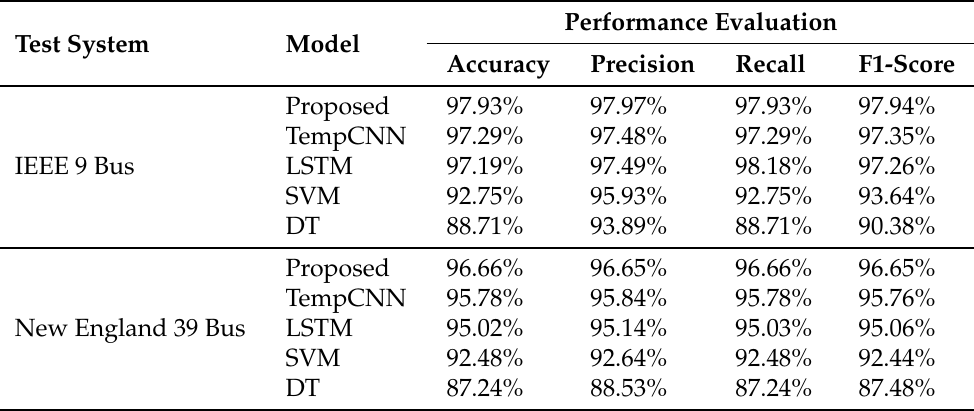
Table 6. Performance evaluation with PMUs measurement error on test